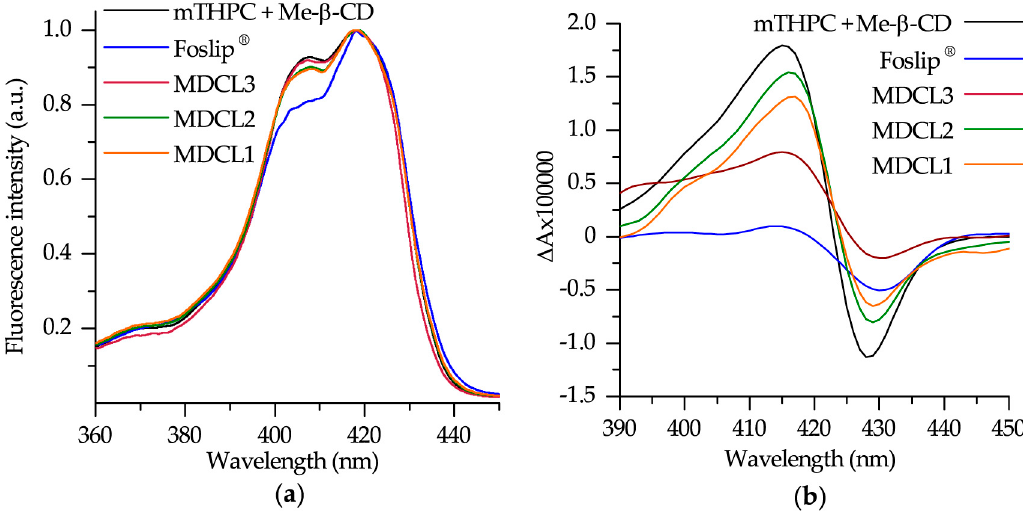
Figure 2. ( a ) Normalized fluorescence excitation spectra of 1 µ M mTHPC in different formulations. Fluorescence signal was measured at 652 nm. ( b ) Induced circular dichroism spectra of 1 µ M mTHPC in different formulations. Concentration of Me- β -CD was 0.2 mM.